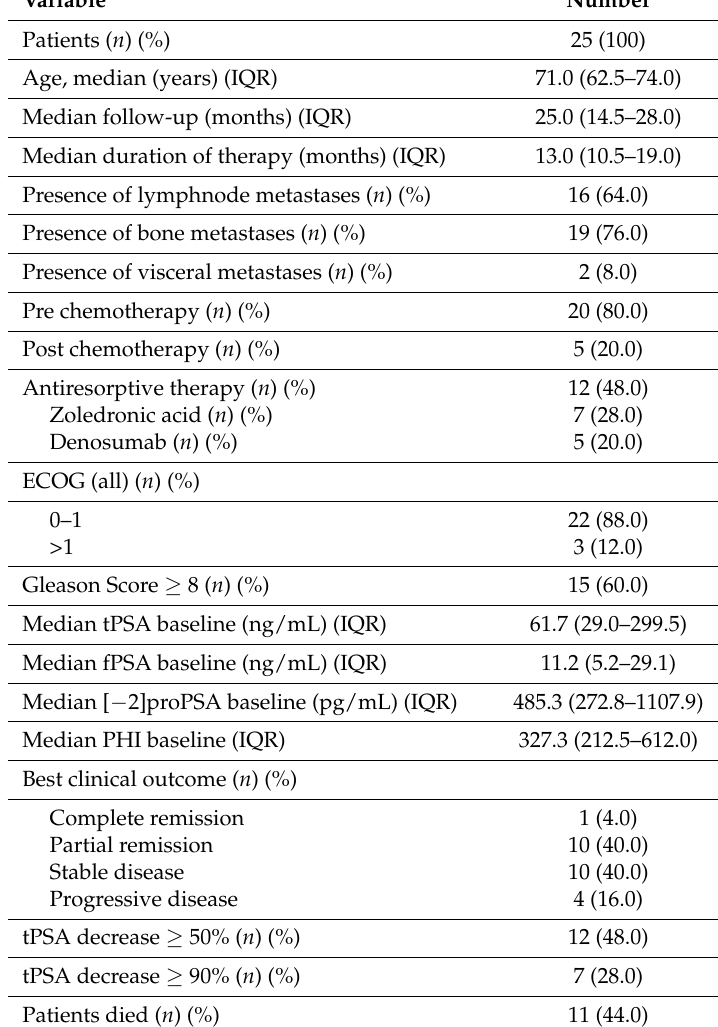
Table 1. Baseline characteristics of patients with mCRPC under therapy with Abiraterone IQR, interquartile range; ECOG, eastern cooperative oncology group performance